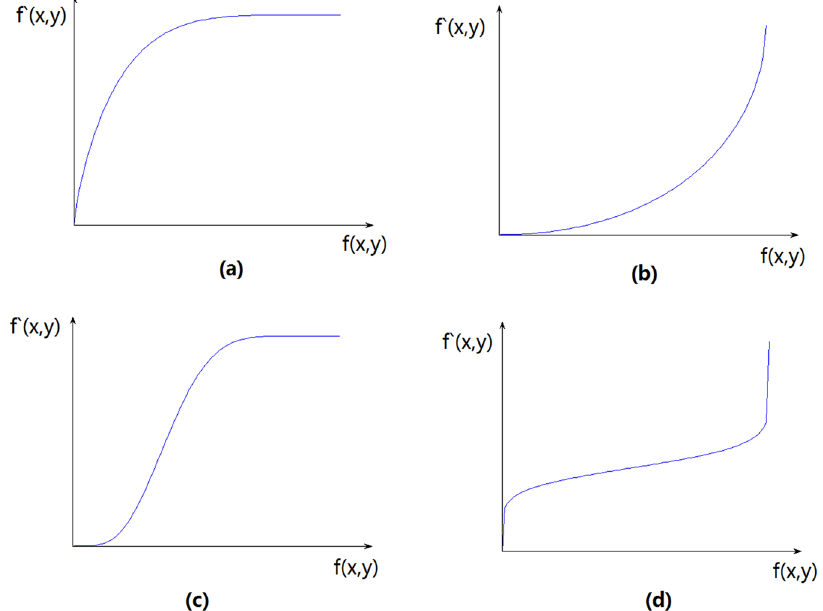
Figure 2. Four types of nonlinear transformation for greyscale image enhancement: ( a ) a transform stretching dark regions; ( b ) a transform stretching lighter regions; ( c ) a transform stretching the middle and compressing the two ends; ( d ) a transform compressing the middle and stretching the two